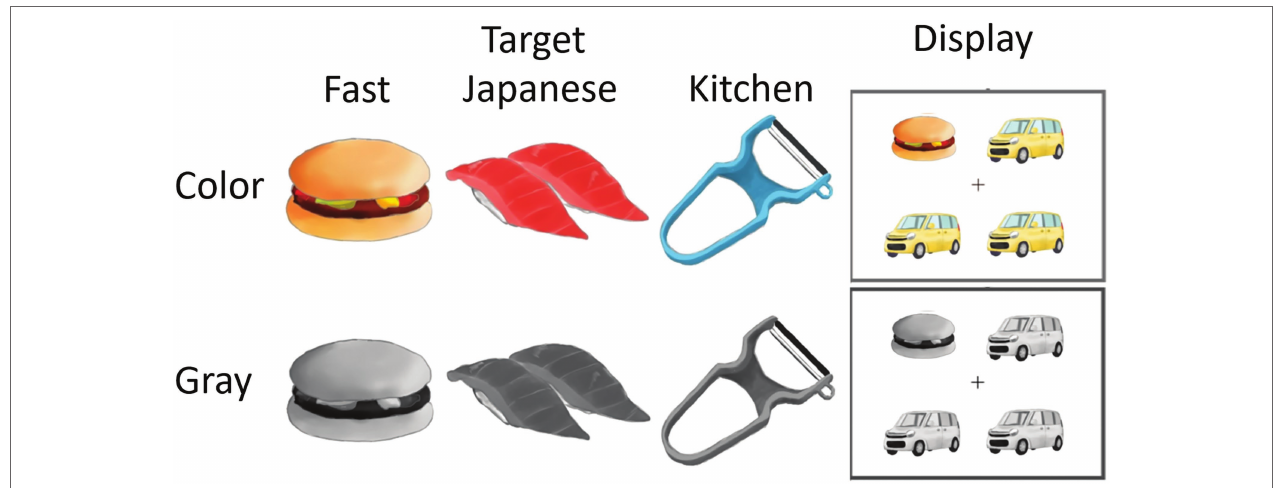
FIGURE 1 | Illustrations of target stimuli (left) and the display (right) in the visual search task in the color and gray modes. Photographic stimuli were used in the actual